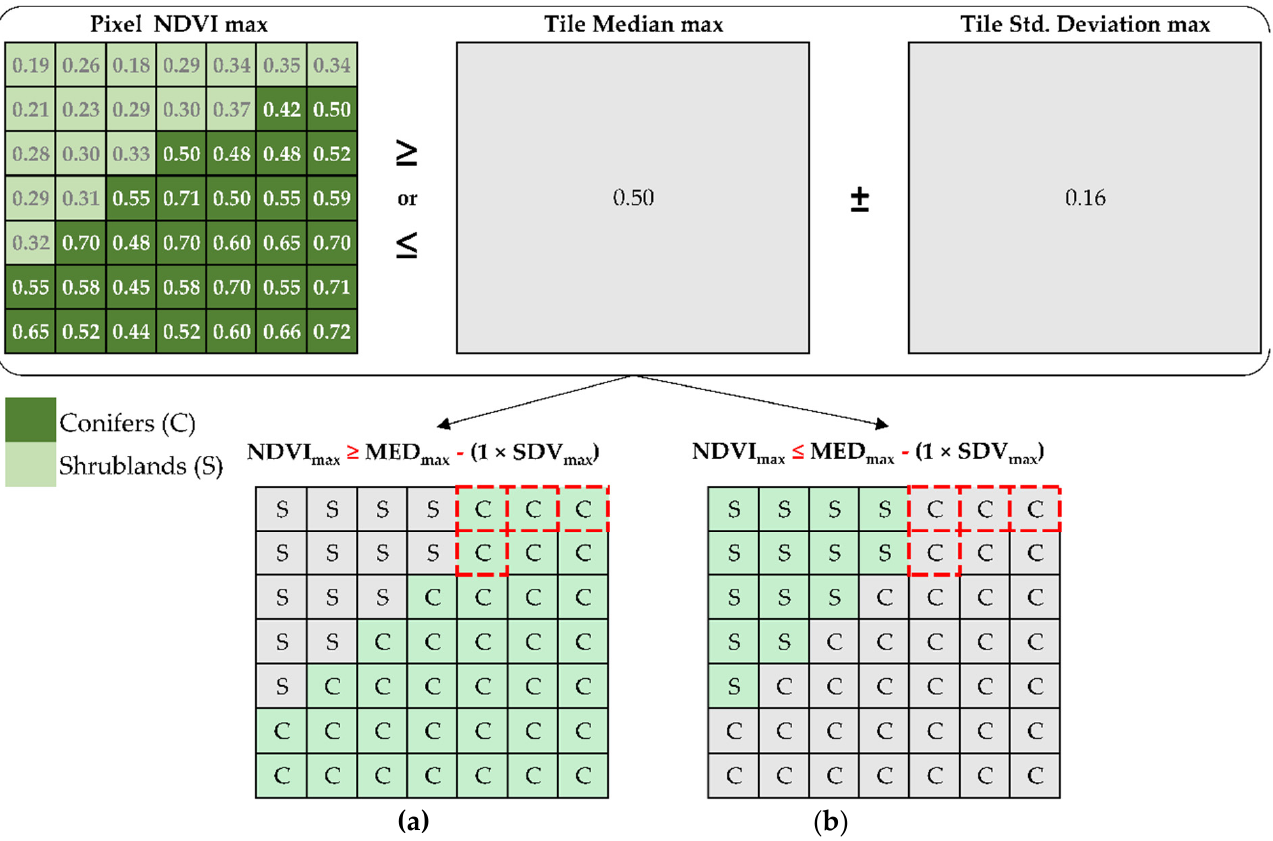
Figure 9. Rule 1 application in a tile polygon. Transitional locations (red squares) with anomalous NDVImax values were selected (green colour) in the left selection ( a ) but unselected in the right ( b ). Establishing additional NDVI thresholds (detailed in rule 2) makes it possible to better control the transitional values in composite land cover polygons.